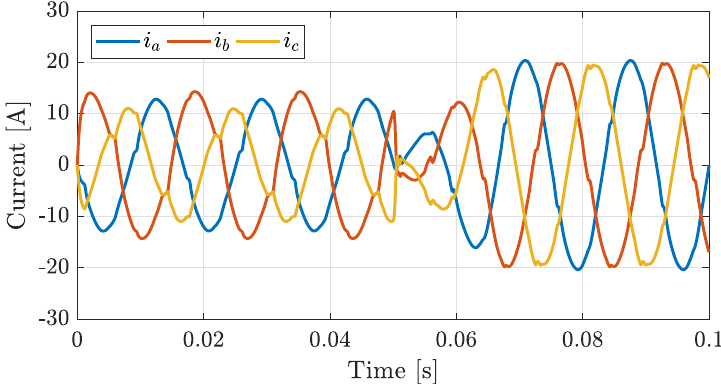
Figure 11. Current correction by the hybrid PI-LQR control action under unbalanced linear and nonlinear load